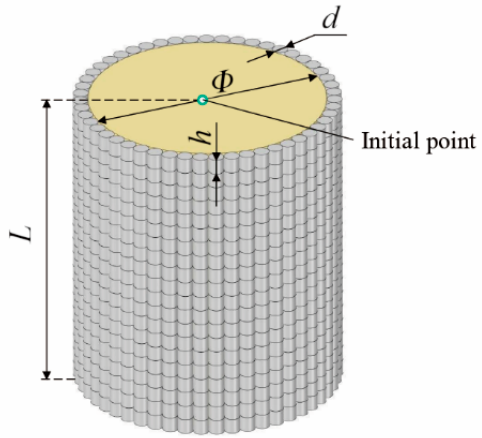
Figure 1. Schematic geometry of the preformed fragment LYPGW. Table 1. Geometric dimensions of the preformed fragment LYPGW.